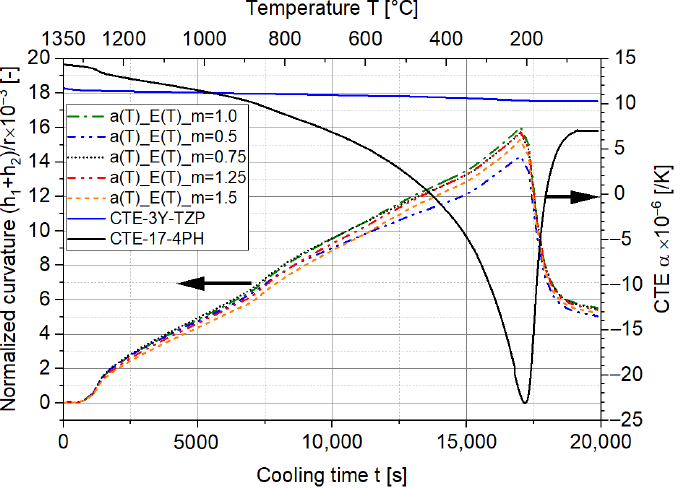
Figure 15. The influence of the height ratio on the normalized curvature of the two-layer MCLs based on the FE simulation.